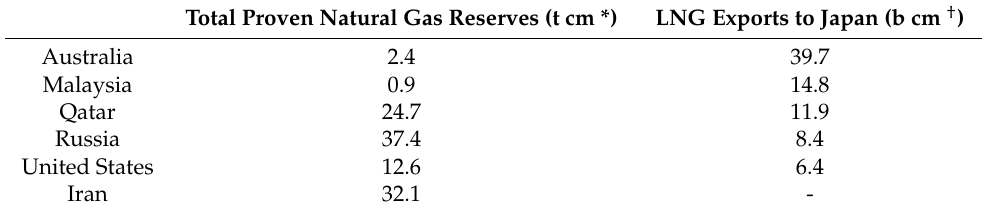
Table 1. Japanese LNG import data by country, 2020. Data collected from [4]. Total Proven Natural Gas Reserves (t cm